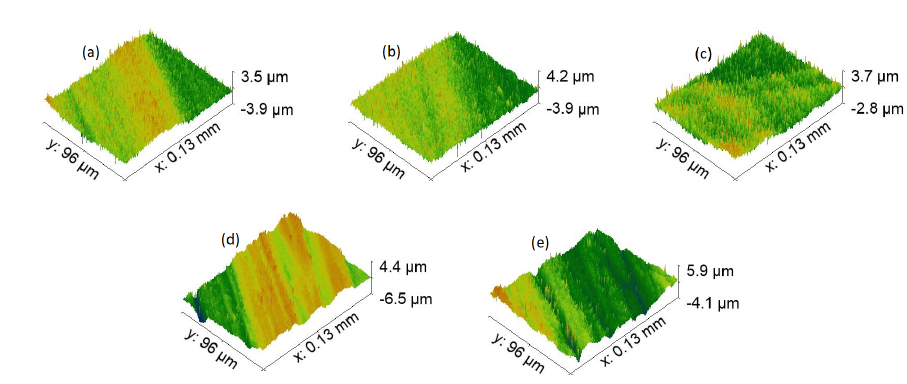
Figure 6. Topography, with × 50 magnification of each sample dimple texture. ( a )—17-4PH stain- less steel, ( b )—PH13 stainless steel, ( c )—Ti6Al4V titanium, ( d )—2024 T3 aluminum, and ( e )—7050 aluminum.